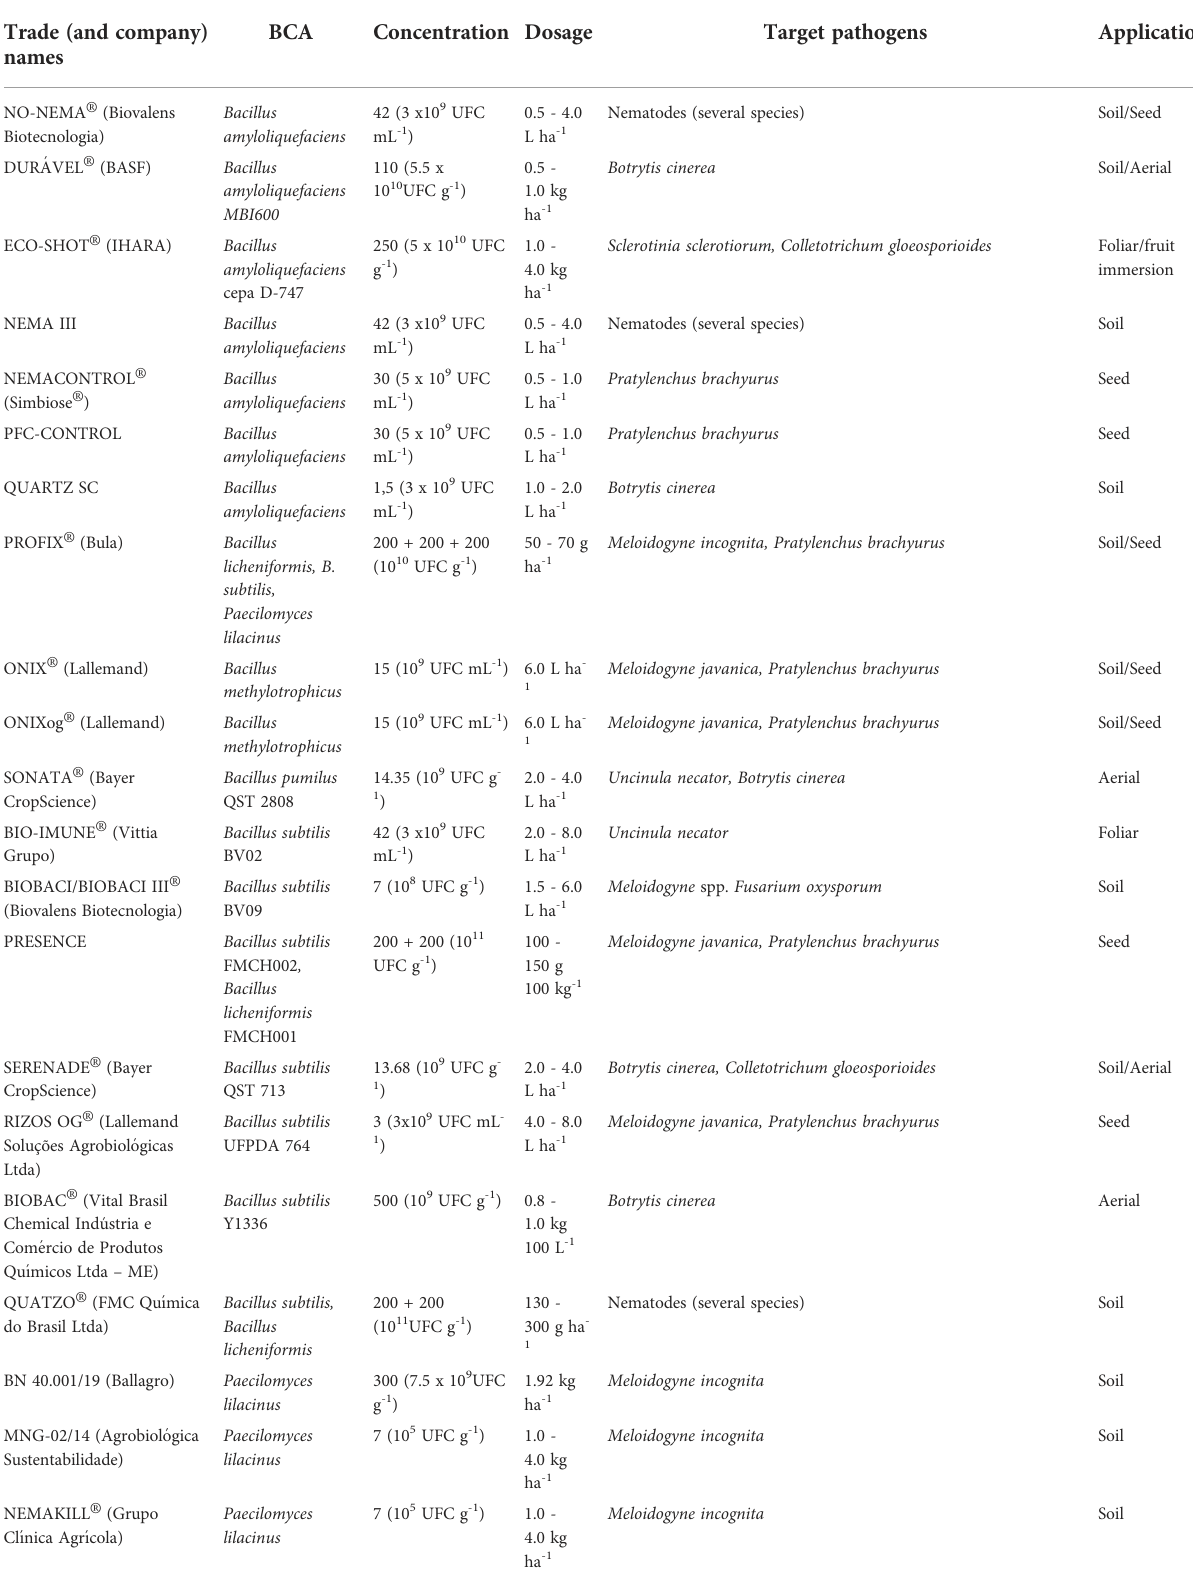
TABLE 7 Principal biological control agents (BCAs) applied in viticulture in